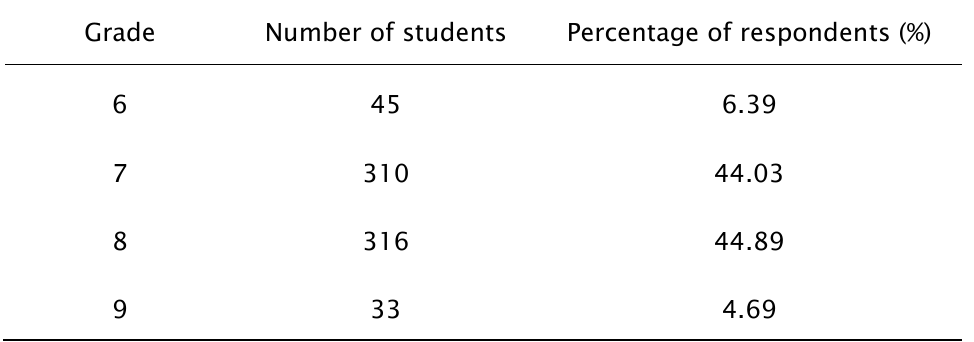
Student Respondents by